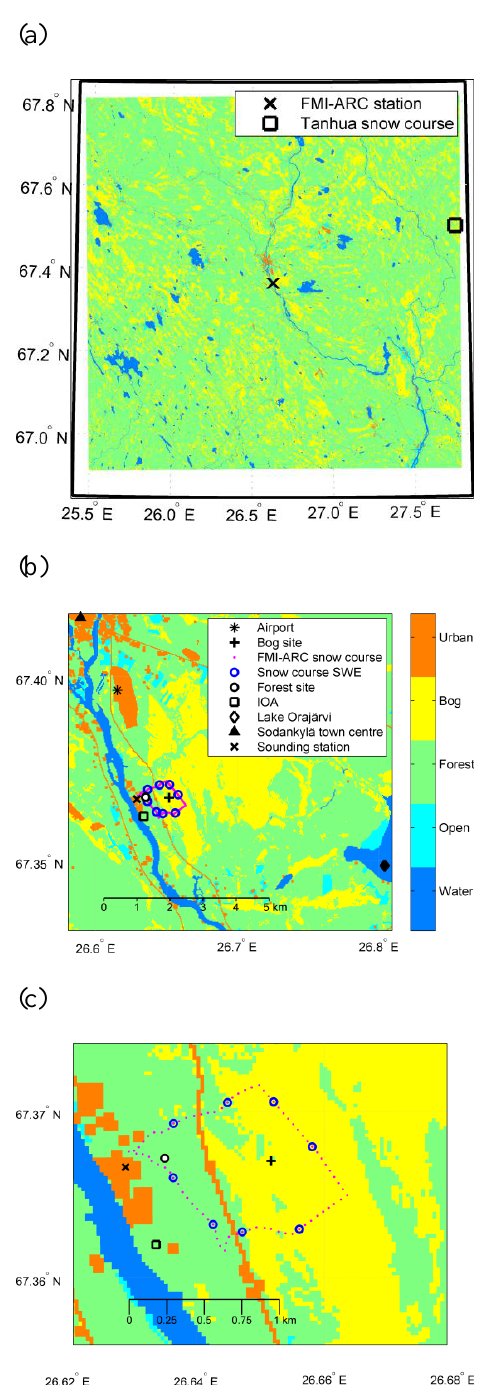
Figure 1. Maps of (a) the 100km × 100km area around FMI-ARC station, (b) the FMI-ARC station and surroundings, and (c) a close- up of the FMI-ARC station area with the manual measurement sites. In (b) and (c) , individual measurement locations of the snow course are marked. The legend and colour scale of maps (a) and (c) are the same as in (b) . All the maps are in orthographic projection. The background of the maps is Corine Land Cover 2006 aggregated into five general